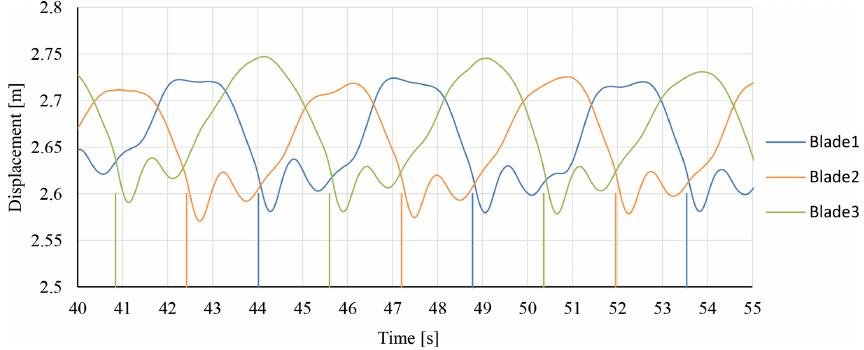
Figure 13. Blade’s flapwise displacements.